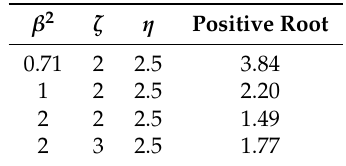
Table 1. Positive roots for some values of